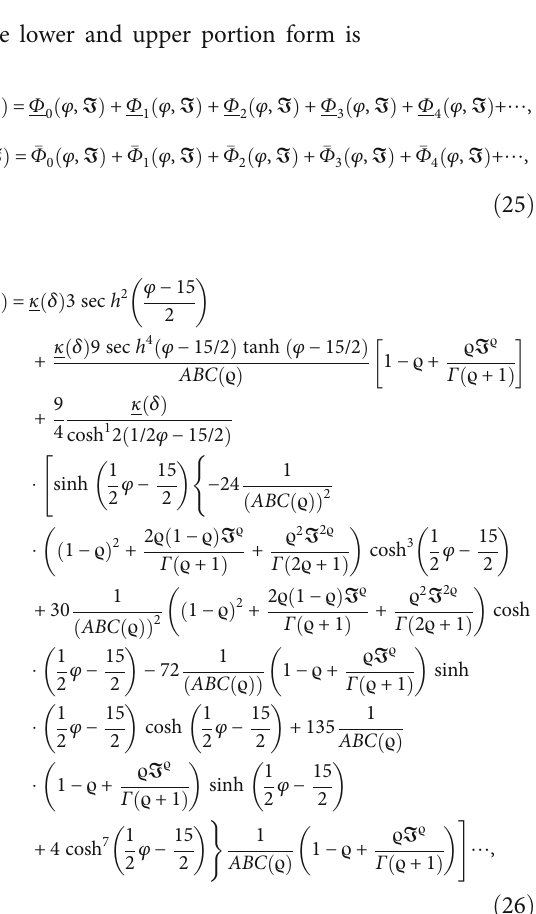
Figure 1(a) shows the three-dimensional fuzzy upper and lower branch graph of approximate series result at ϱ = 1 and Figure 1(b) at fractional-order of ϱ = 0 : 8 .